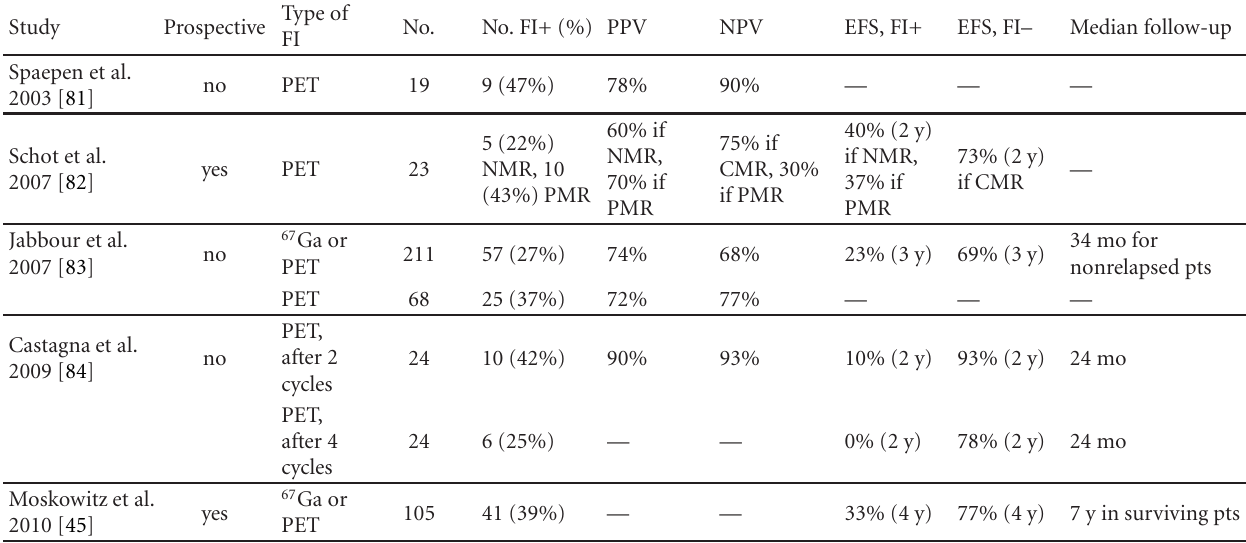
Table 3: Selected studies of pretransplantation PET in relapsed/refractory Hodgkin’s lymphoma.